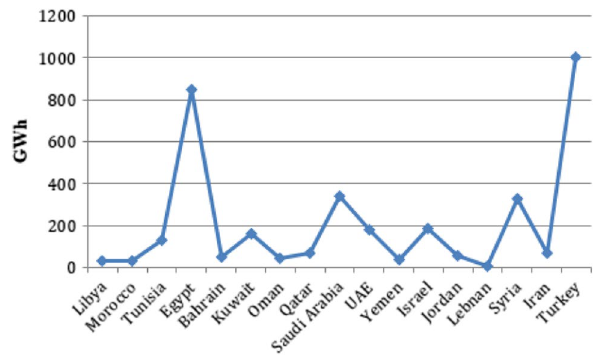
Fig. 7 Energy required for the wastewater treatment in MENA region (Tabakovic and Poci